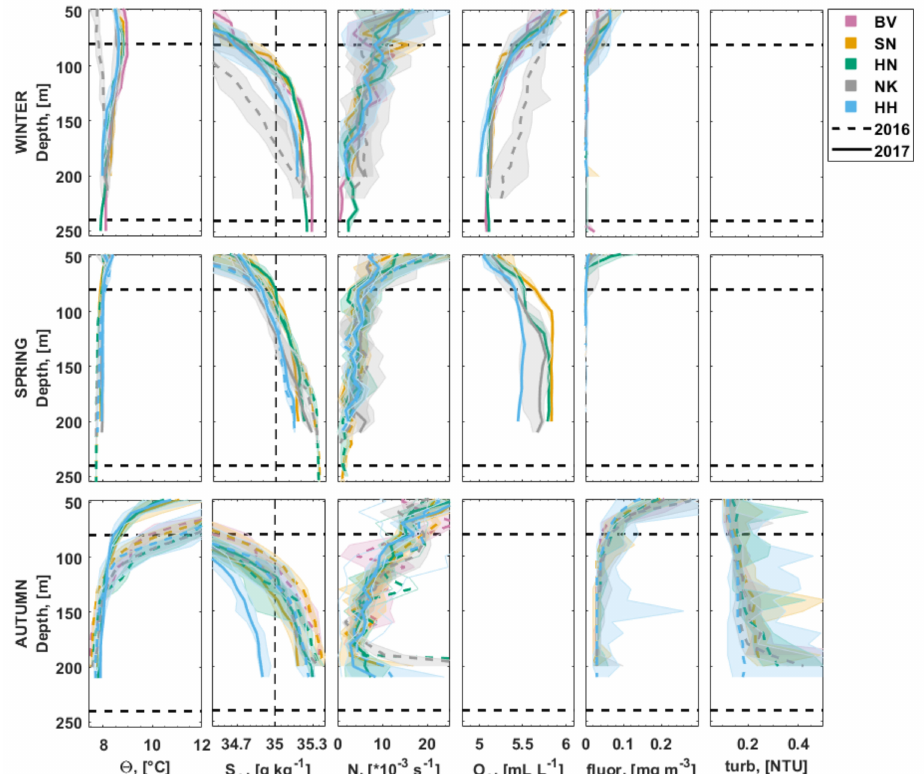
Figure 2. Depth profiles (y-axes) of hydrographic water properties at depths 50–250 m of the Langenuen Fjord: (first row) winter (February 2016 and January 2017), (second row) spring (April 2017 and May 2016), and (third row) autumn (August 2017 and October 2016), for (first column) temperature, (second column) salinity with 35 g kg − 1 marked, (third column) stratification, (fourth column) oxygen, (fifth column) fluorescence, and (sixth column) turbidity. The shaded area covers the range (min, max) of the variable for the station (HH—blue, NK—gray, HN—green, SN—orange, BV—purple) over the cruises and the solid (for year 2017 cruises) or the dashed (for year 2016 cruises) line shows the median value. The dashed horizontal lines represent the definition for CWC living depths (80–240